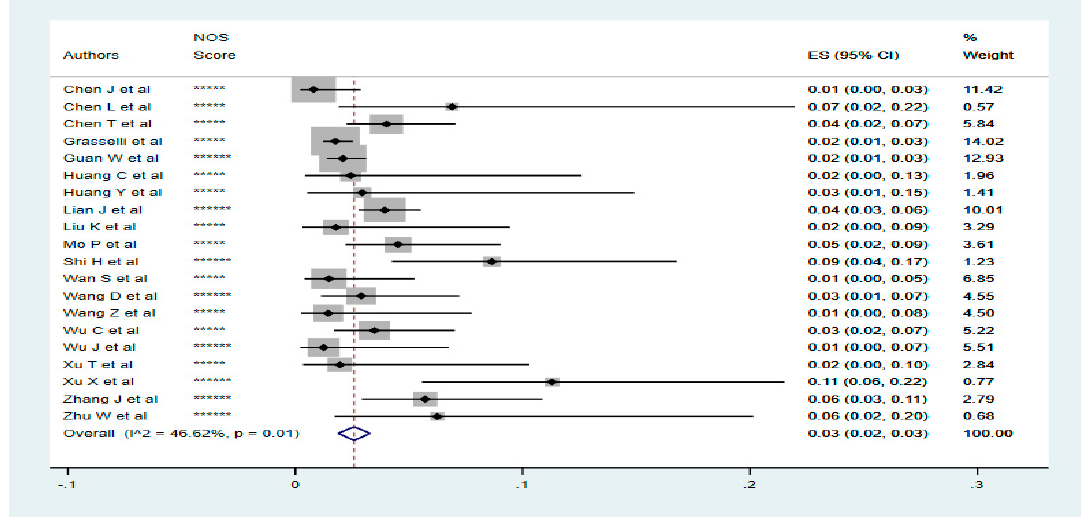
Figure 3. Pooled prevalence of patients with liver diseases (Chronic Liver Diseases, Hepatitis B/C infections) diagnosed with COVID-19. The red dotted line represents the overall effect size of the studies (0.03). The edges of the blue diamond represent 95% confidence intervals (0.02, 0.03). ES = Effect Size, NOS = Newcastle-Ottawa Score.